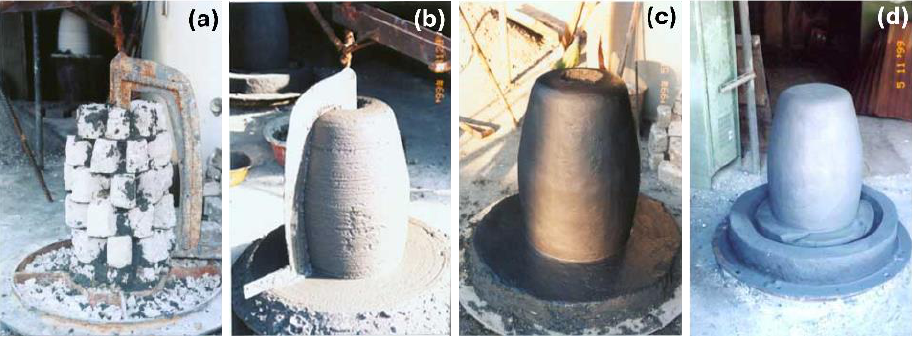
Figure 12. The fabrication process of the bell core using rotational molding. ( a ) Building core bricks, ( b ) rotational molding, ( c ) mold wash coating, and ( d ) core drying [11]. When the core is completed, beeswax is applied while rotating according to the thick- ness of the bell, and then the surface is finely trimmed to finish. To improve the fluidity,